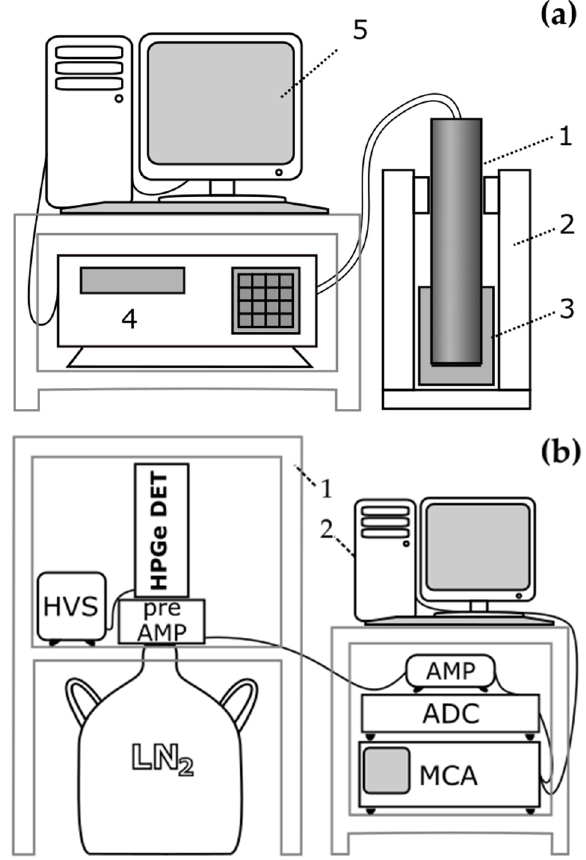
Figure 2. Diagram of experimental apparatus; ( a ) MAZAR: the scintillation probe (1) has been placed in a lead shielding unit (2) with a Marinelli beaker (3) filled with the sample being tested. Its geometry allows pushing the probe (1) into the containers to enable detection of gamma photons from almost the full solid angle. Photons reaching the scintillator are analyzed by the MAZAR spectrometer (4), and the software installed in the PC (MAZAR PC 2007, provided by POLON-IZOT Ltd., Warsaw, Poland), (5) allows observing the spectrum, and calculations of concentrations and radionuclides; ( b ) HPGe: signals from the tested samples are preliminary amplified in a charge-sensitive preamplifier then measured in the LN 2 —cooled germanium detector. The produced electric signal is then amplified in the amplifier, transformed from analog to digital information via AD converter and analyzed in the multi-channel analyzer, then treated in the PC software. Legend: HVS—high-voltage power supply, HPGe DET—germanium detector with a Marinelli container attached,